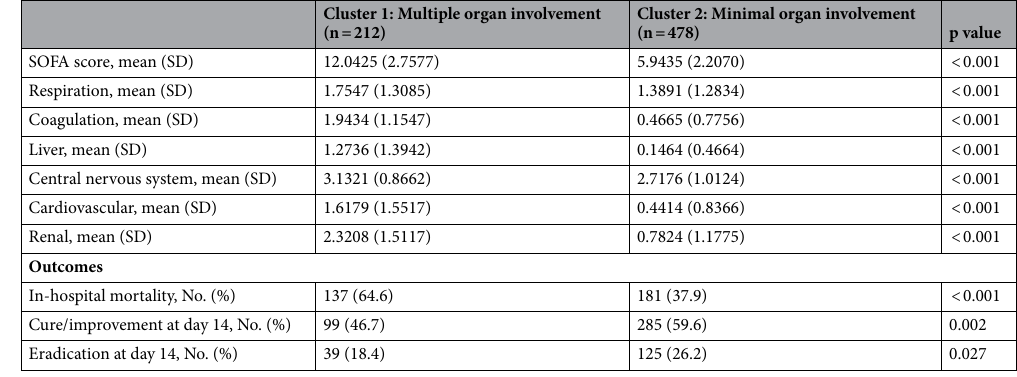
Table 3. SOFA subscore data and clinical outcomes of the two clusters. SD standard deviation, SOFA Sequential Organ Failure Assessment.